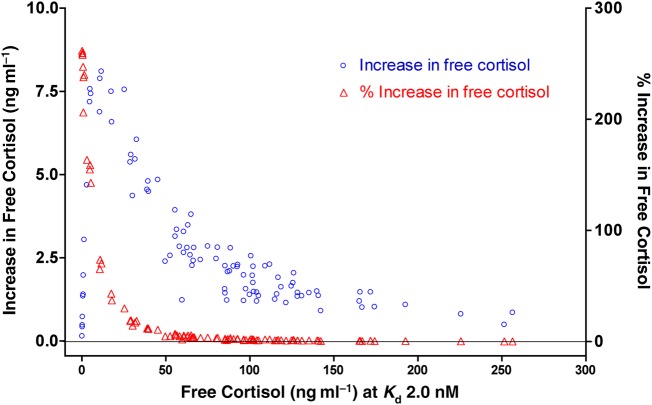
Given that our estimates of Kd for individual Richardson's ground squirrels ranged from 2.0 to 7.3 nM, we wanted to determine whether this difference was likely to have a significant effect on free hormone levels. This depends on the real GC concentrations and CBG capacity of individuals, so we used those data from 96 Richardson's ground squirrels studied in our previous studies (Delehanty and Boonstra, 2009, 2012), which had been measured in baseline or acute stress conditions. The figure shows the absolute (circles; left y-axis) and percentage increase (triangles; right y-axis) in free GC when the Kd is increased from 2.0 to 7.3 nM.